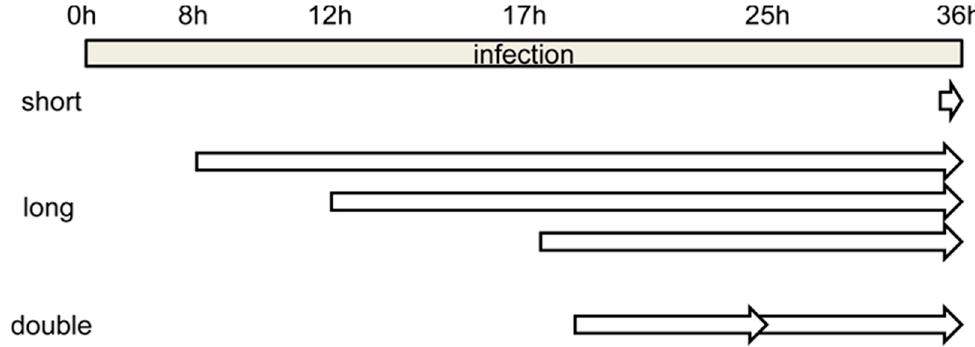
Figure 2. Schematics showing the time frame for the different BrdU labeling strategies tested. Short, long and double refer to incubation with BrdU for short or long time periods, or for long periods with two pulses of BrdU added (see text for details).